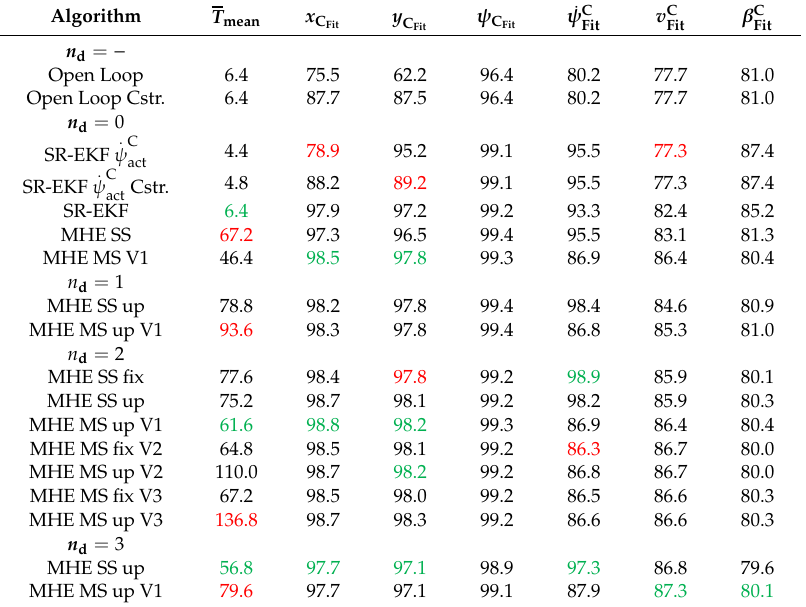
Table 1. Comparison of the vehicle position observer performance indicators. SR-EKF—square-root extended Kalman filter; MHE—moving horizon estimation / estimator; MS—multiple shooting; SS—single